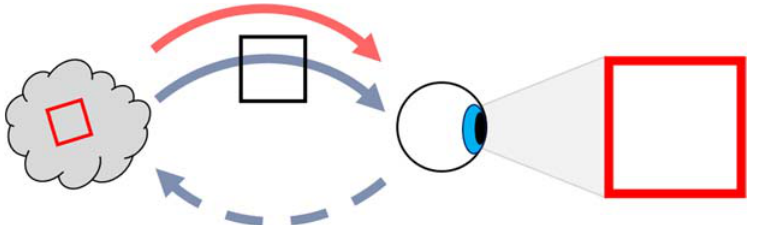
Figure 3. The brain sends two signals to the eye to construct an image and receives the feedback of